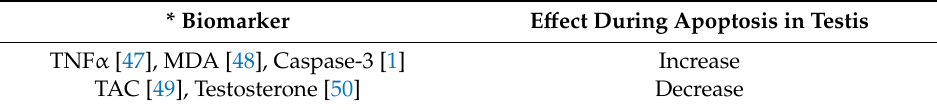
Figure 5. Photos of testicular specimens for groups of sham, I / R, reference ( N -acetylcysteine, NAC) and treated with compounds 6a – g . Table 3. The expression of the biomarkers during apoptosis in